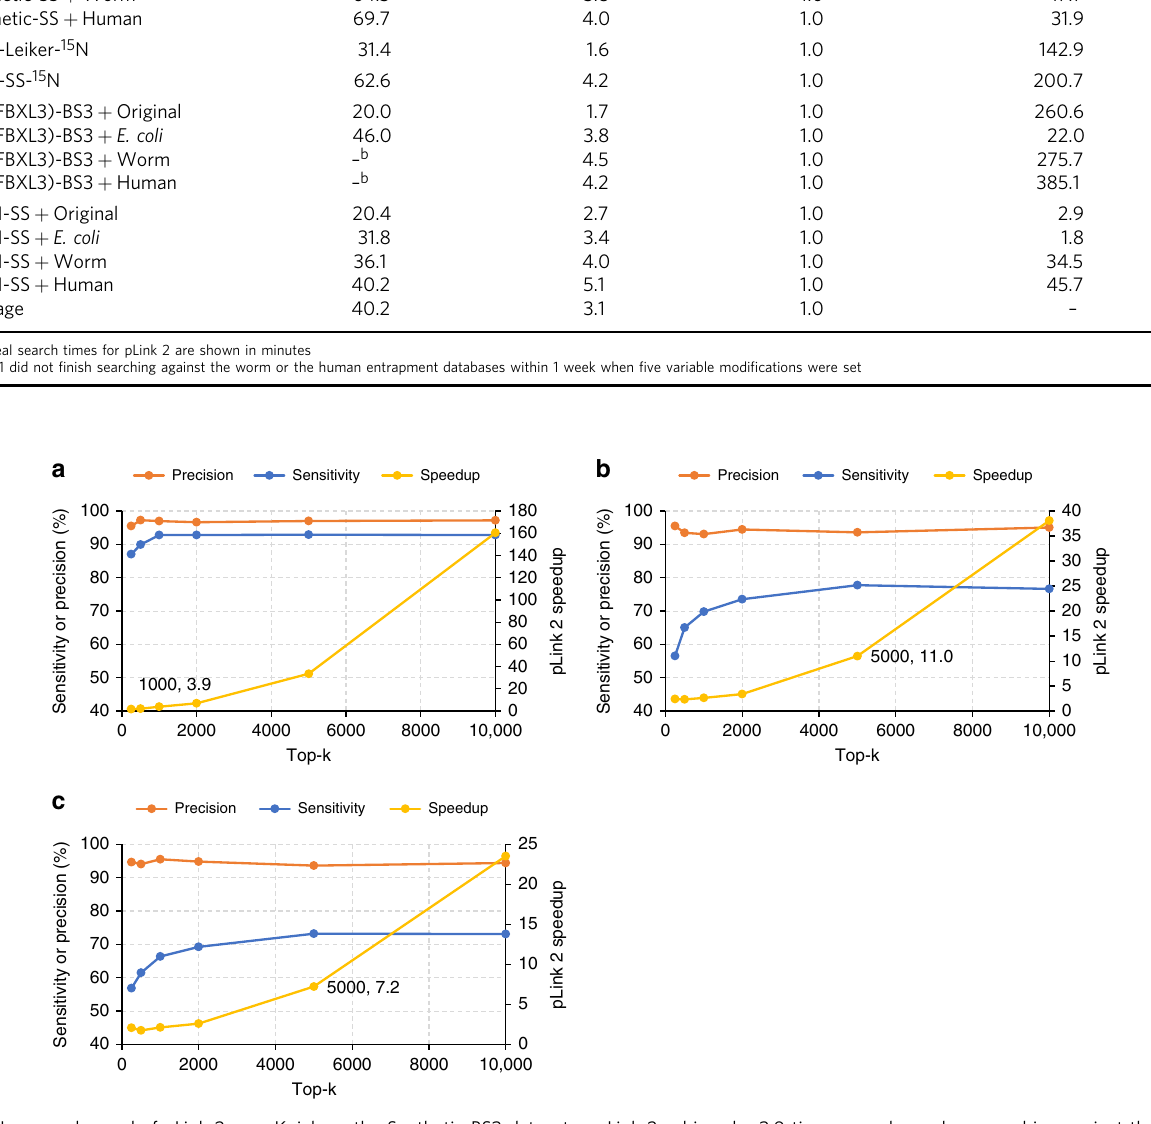
Fig. 5 Increased speed of pLink 2 over Kojak on the Synthetic-BS3 dataset. a pLink 2 achieved a 3.9 times speed-up when searching against the E. coli entrapment database. The horizontal axis is the number of top- k scored single peptides kept in Kojak, starting from its default value of 250. Speed-up was measured when the sensitivity of Kojak remained steady. b , c Similar to a , but against b the worm and c the human entrapment database,